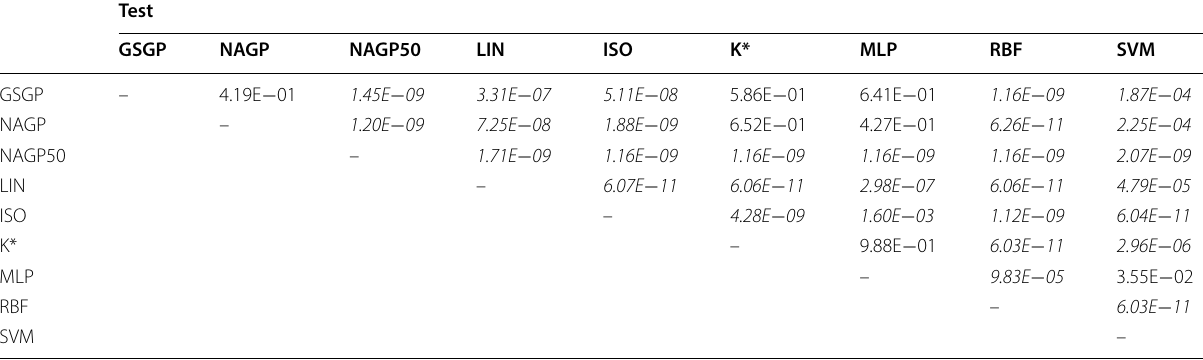
Italic is used to denote statistically significant differences between the considered